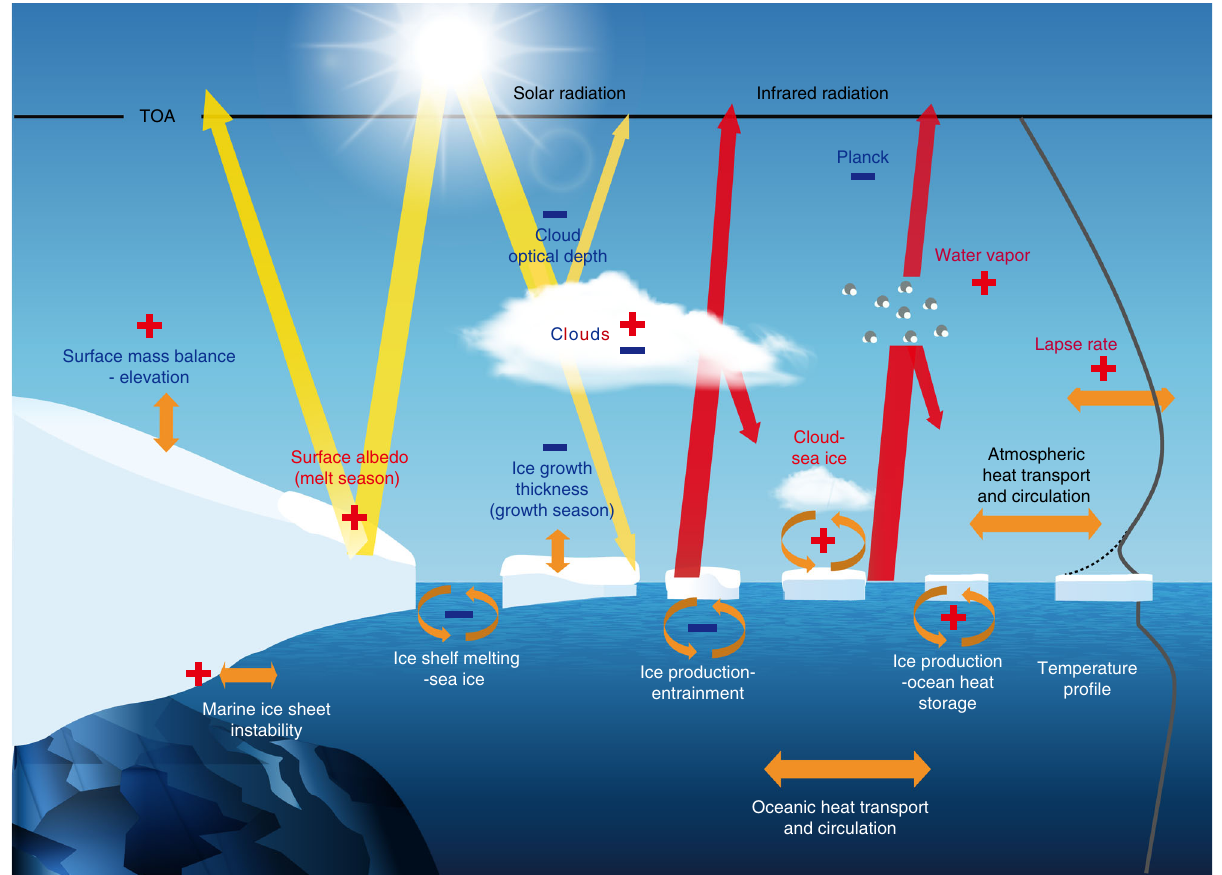
Fig. 1 A schematic of some important radiative and non-radiative feedbacks in polar regions involving the atmosphere, the ocean, sea ice and ice sheets. TOA refers to the top of the atmosphere. Solar radiation (in yellow) and Infrared Radiation (in red) represent the shortwave (solar) and longwave (infrared) radiation exchanges. A red plus sign means that the feedback is positive, a negative blue sign corresponds to a negative feedback. Both signs are present for cloud feedbacks as both positive and negative feedbacks are occurring simultaneously and the net effect is not known. The gray line on the right represents a simpli fi ed temperature pro fi le in polar regions for the atmosphere and the ocean, the dashed line corresponding to a strong surface inversion. Oceanic and atmospheric heat transport are mentioned but without signs as the processes involved are not restricted to polar regions and it is not clear if they could be formally expressed using a closed feedback